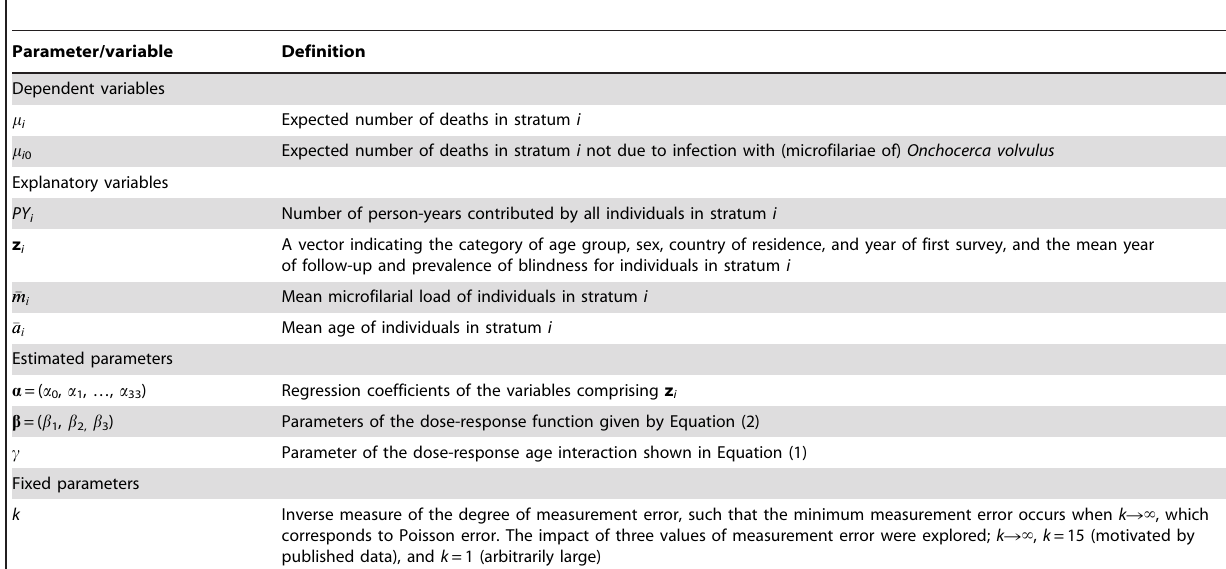
Table 2. Definitions of parameters and